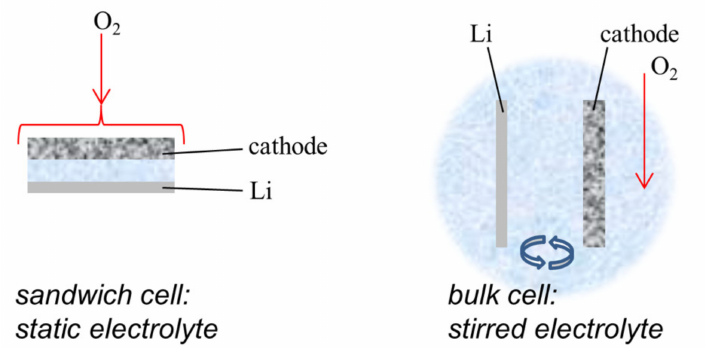
Figure 3. Sketch highlighting the main aspects of the two cell configurations used in this